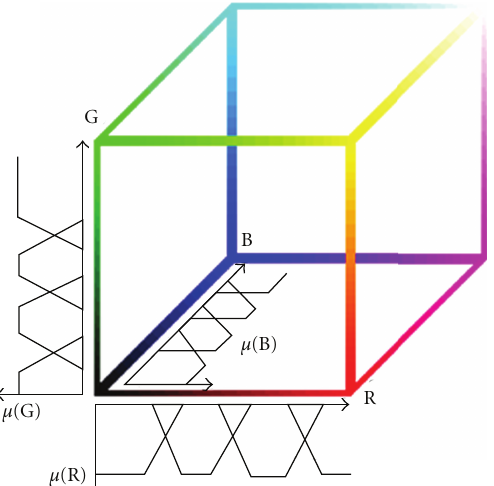
Figure 5: Fuzzy sets of the RGB channels for data input fuzzifica-